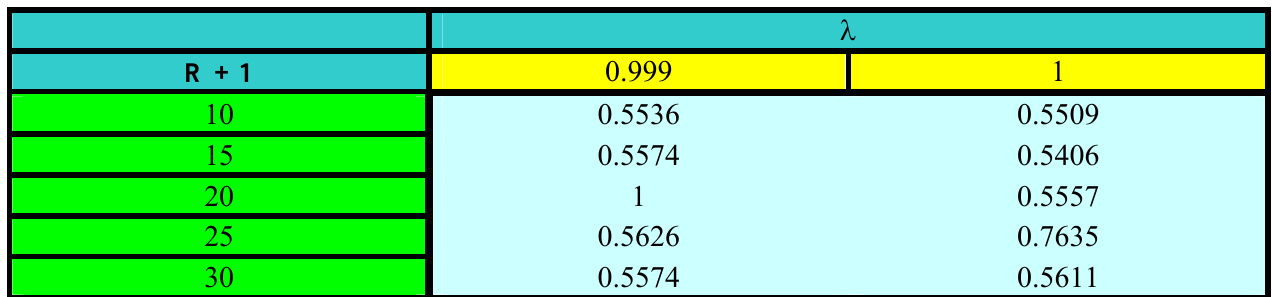
Table 1. Normalized ensemble-averaged mean-squared error of the filter for ten combinations of the length of the filter and the forgetting